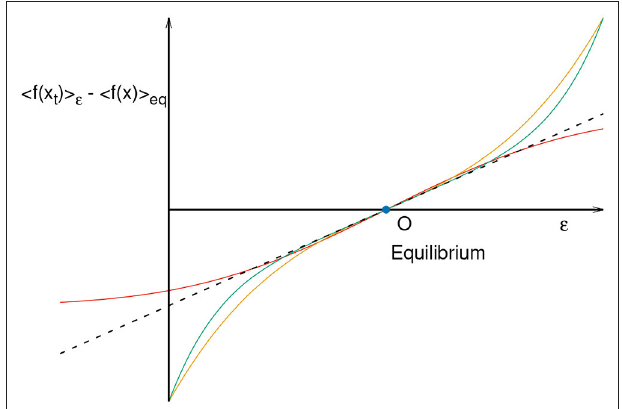
FIGURE 9 | The scenario for non-linear response around equilibrium. The vertical axis shows some displacement as function of non-equilibrium (driving) parameter ǫ . The three functions correspond to different kinetics by which the same thermodynamic perturbation is realized. In linear order, the responses coincide and deviations, much as life itself, start at second order around